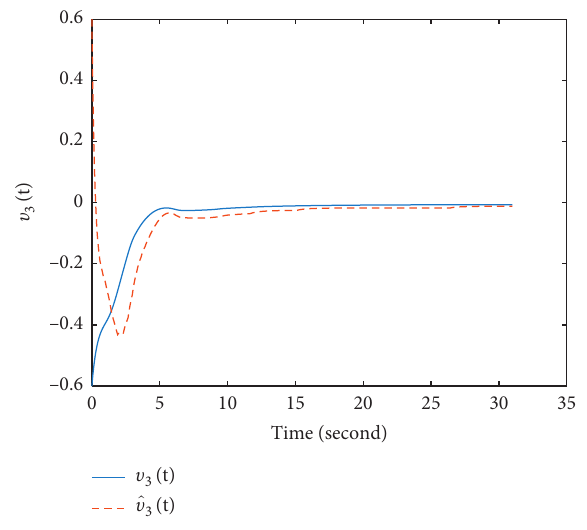
Figure 8: Trajectories of υ